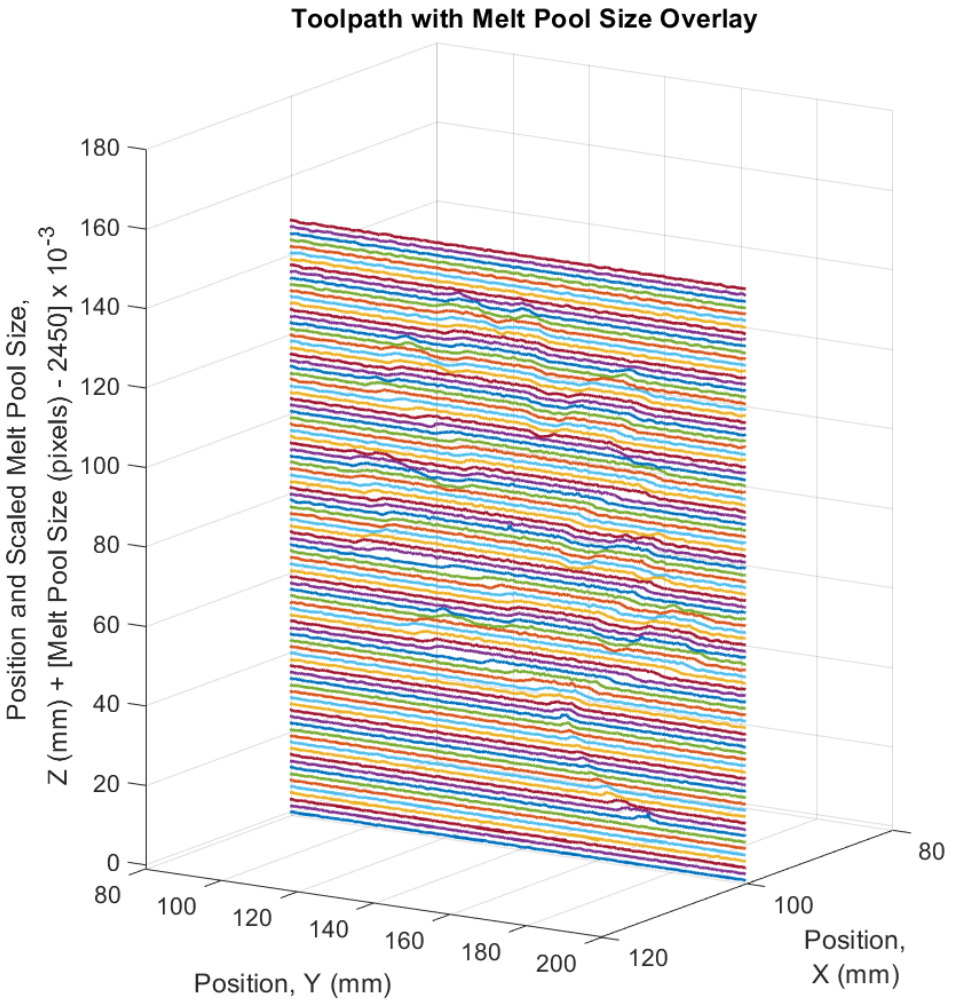
Figure 6. Toolpath with melt pool size overlay for bead one of Wall 2.